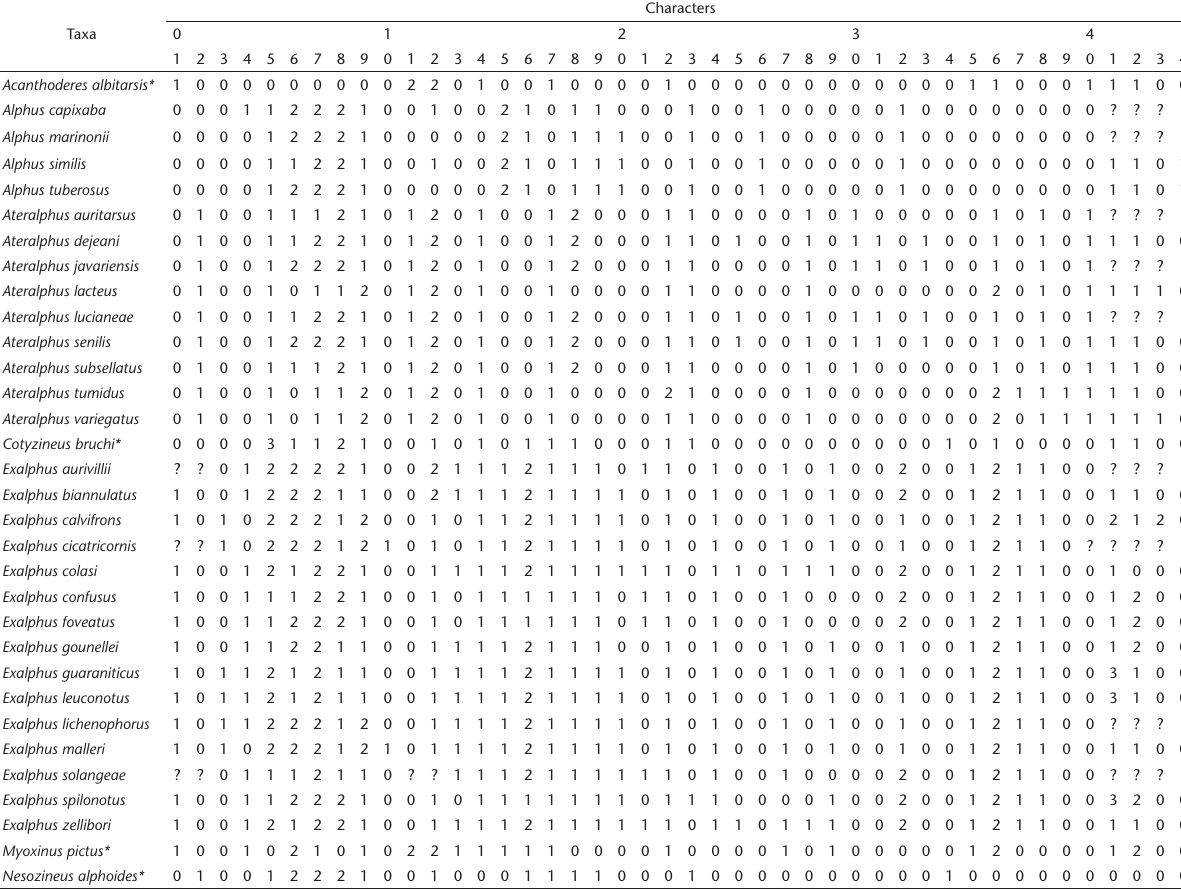
Table 1. Data matrix of morphological characters used in the cladistic analysis of Ateralphus and related genera, Alphus and Exalphus (Coleoptera: Cerambycidae: Lamiinae). Outgroups are indicated with an asterisk.